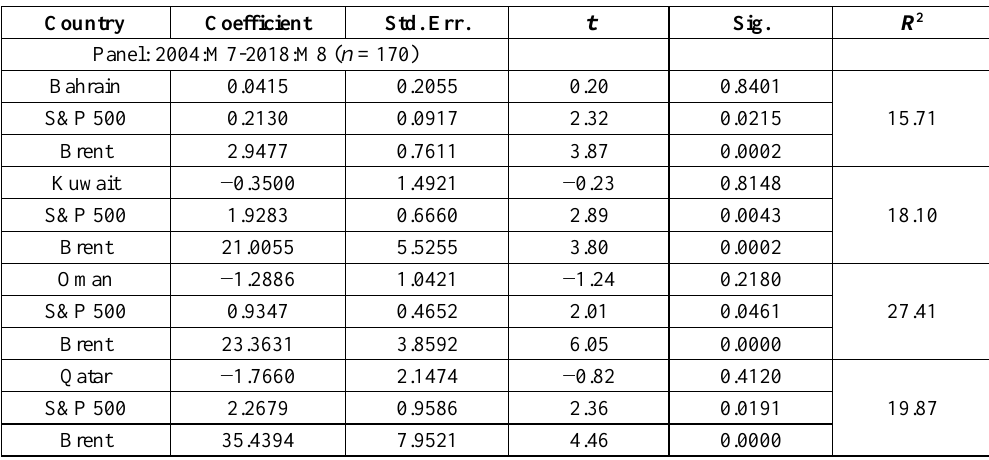
Fig. 6. The impulse response functions of the returns on Saudi Arabia stock Table 4. Regression results with control variables for the impact of the economic policy uncertainty in the U.S. on the monthly returns of each GGC country Country Coefficient Std. Err. t Sig. R